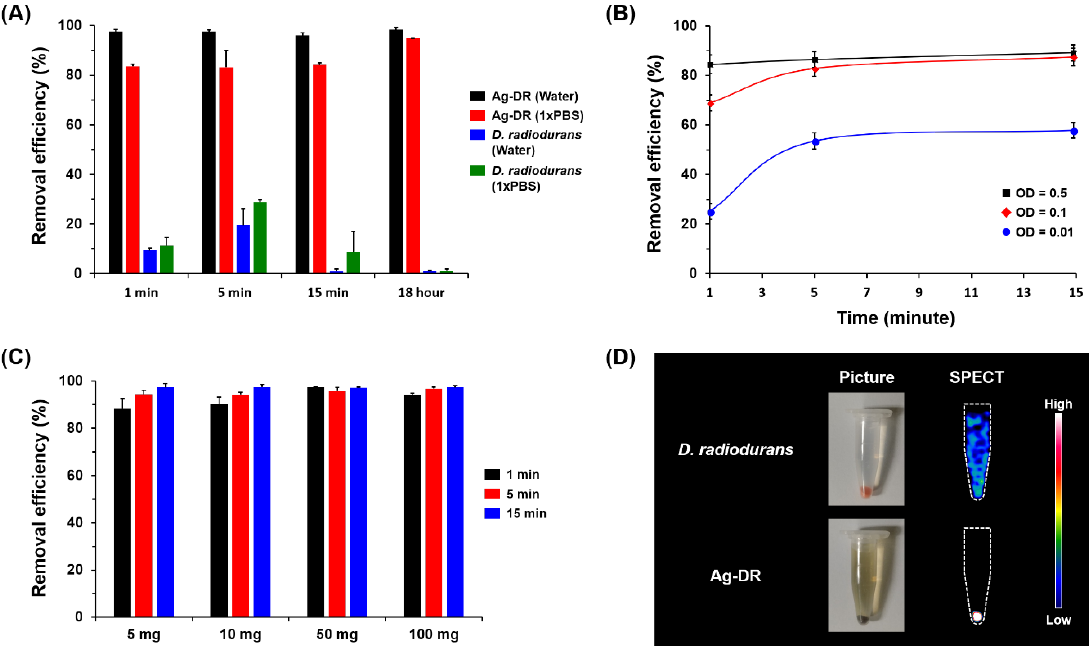
Figure 5. ( A ) Removal efficiency of Ag-DR in water and 1× PBS; ( B ) uptake kinetics for removal of radioiodine using smaller concentrations of Ag-DR in water for 15 min (OD = optical density at 600 nm); ( C ) removal efficiency of freeze-dried Ag-DR in water for 15 min; and D ) photographic and SPECT/CT images of Ag-DR and D. radiodurans after 125 I − incubation.